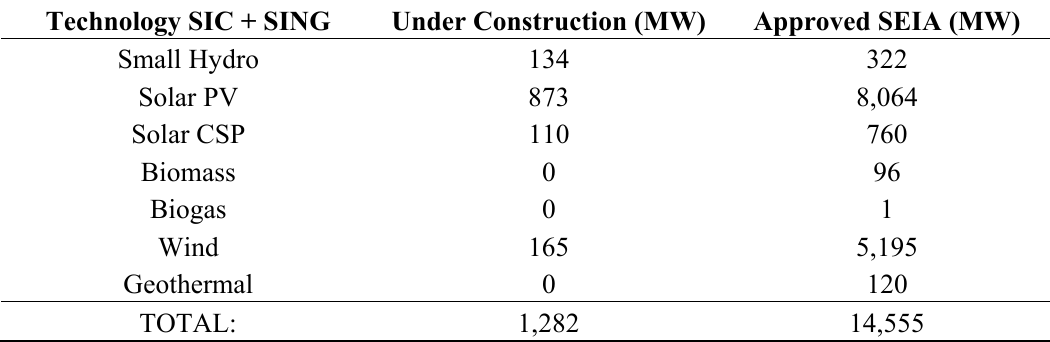
Table 1. The status of Renewable energy projects in Chile in 2014. Technology SIC + SING Under Construction (MW) Approved SEIA (MW) Small Hydro 134 322 Solar PV 873 8,064 Solar CSP 110 760 Biomass 0 96 Biogas 0 1 Wind 165 5,195 Geothermal 0 120 TOTAL: 1,282 14,555 Sources: The data adopted from CIFES